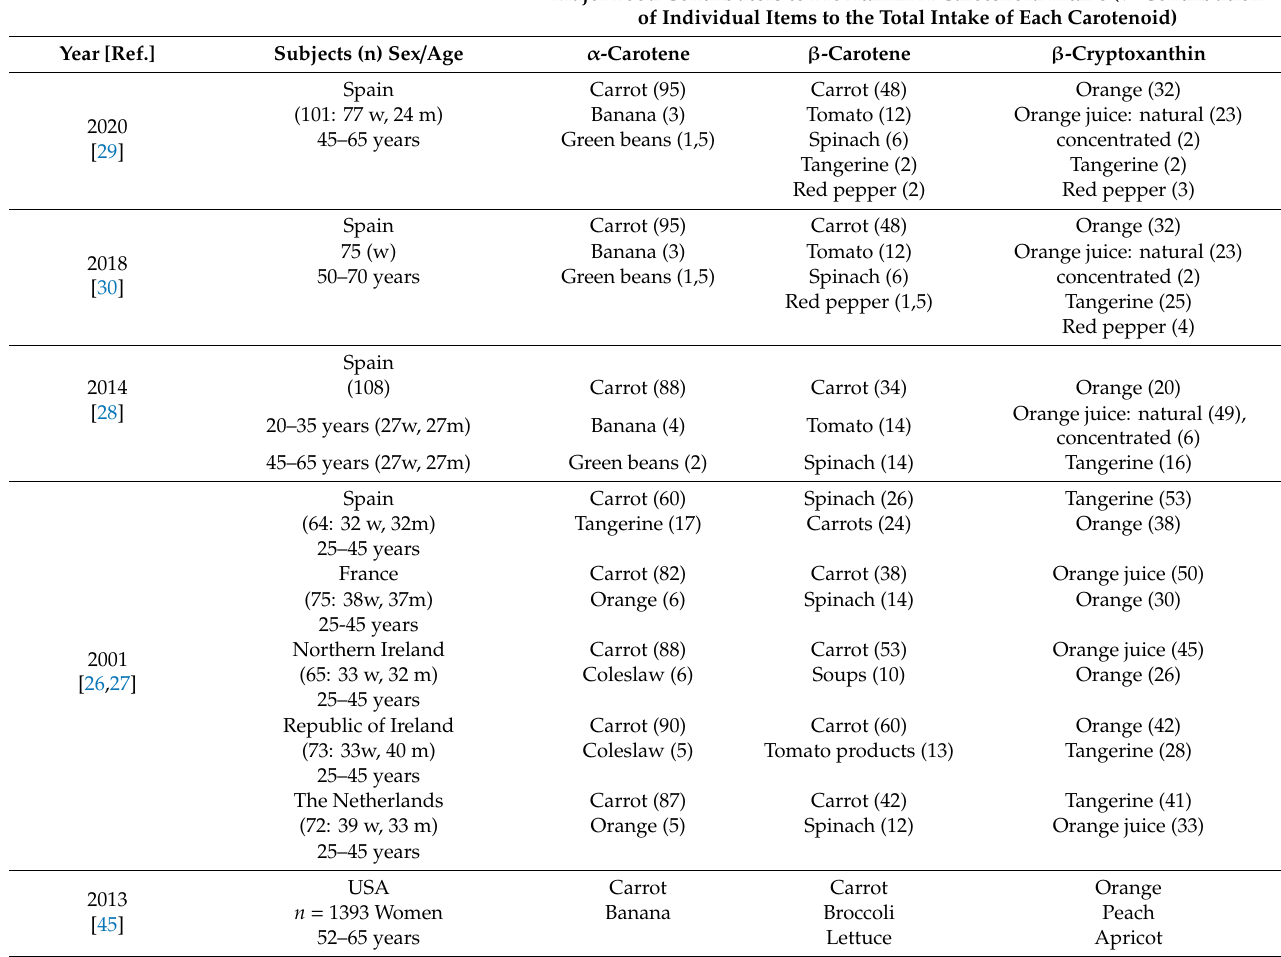
Table 3. Major food contributors to provitamin A carotenoid